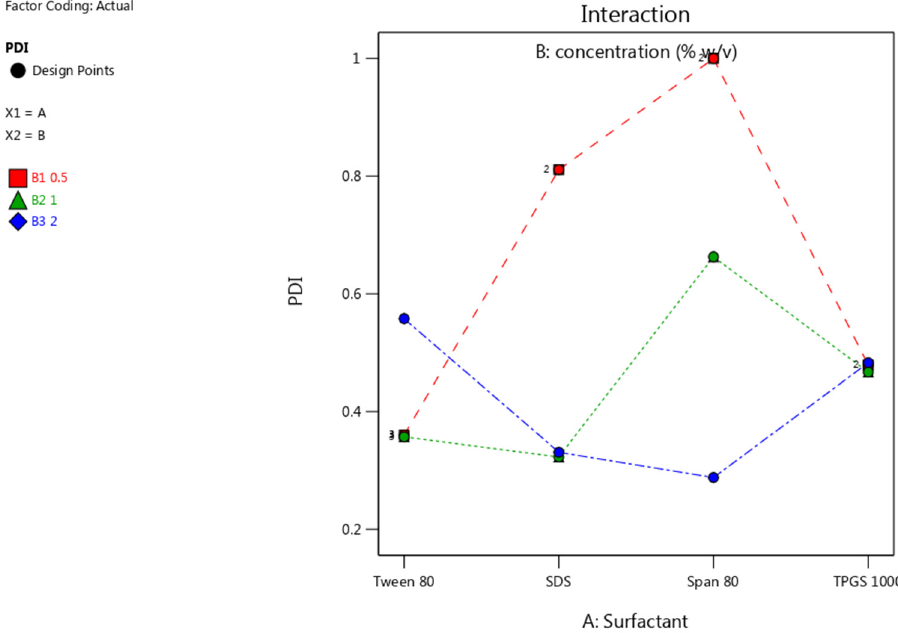
Figure 6. PDI of nano co-crystals using different surfactants at concentrations of 0.5% w/v (red), 1% w/v (green) and 2% w/v (blue).